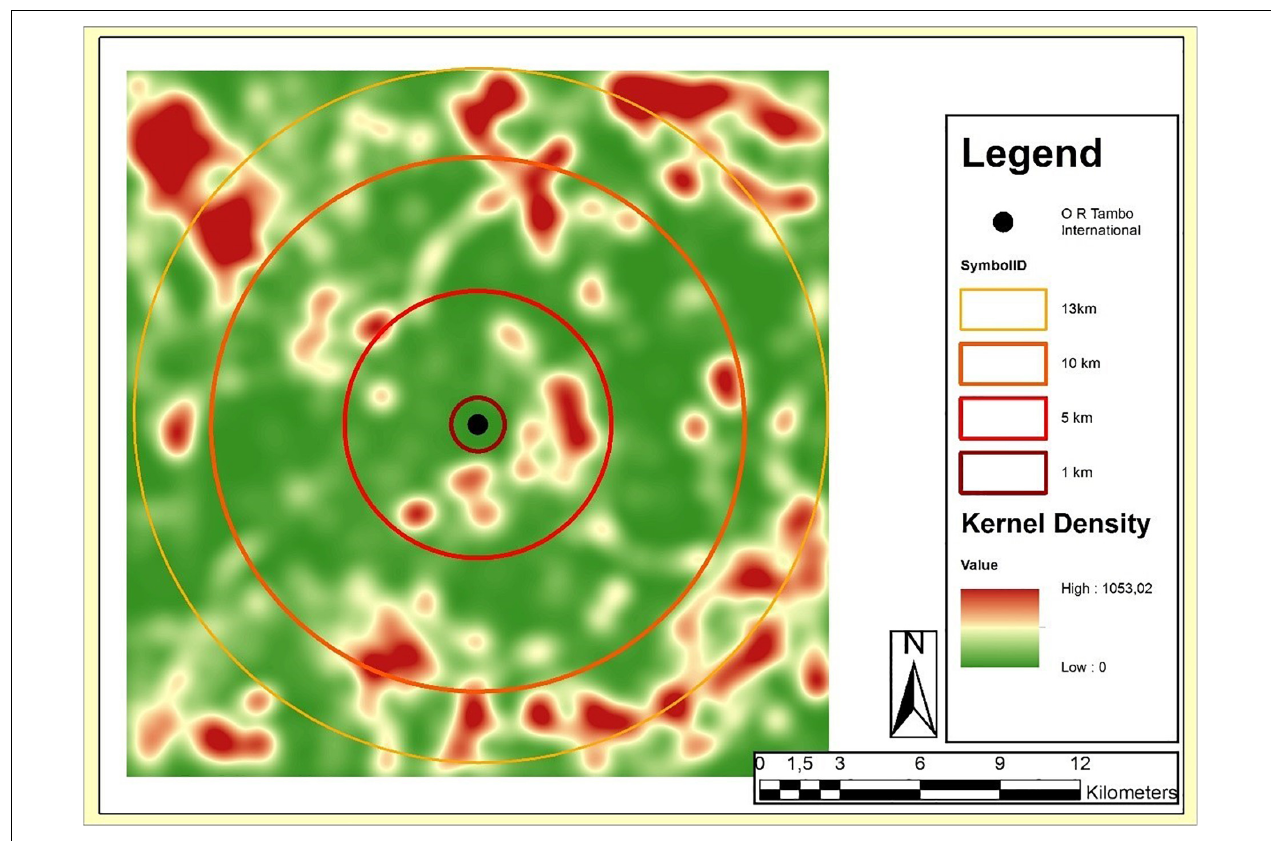
FIGURE 2 | Location of bird strike hazard zone area around OR Tambo International